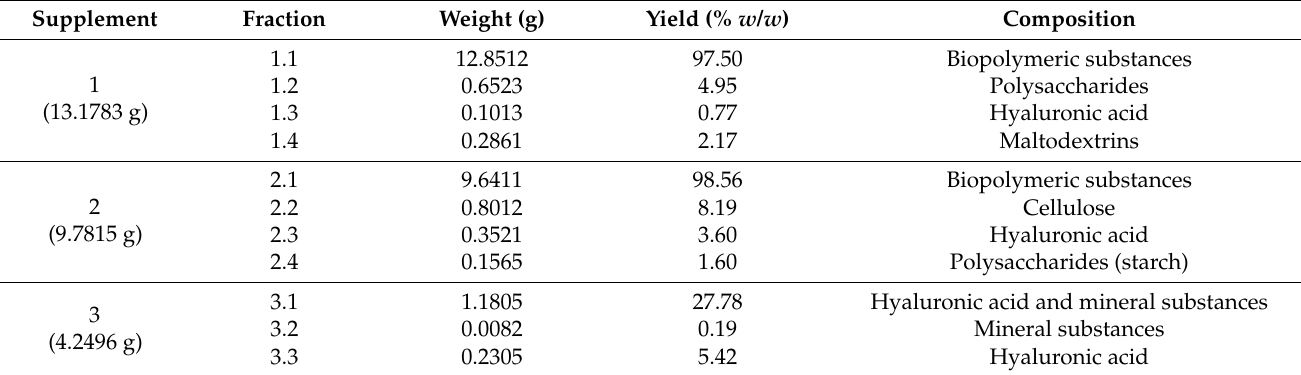
Table 2. Yields and composition of the obtained